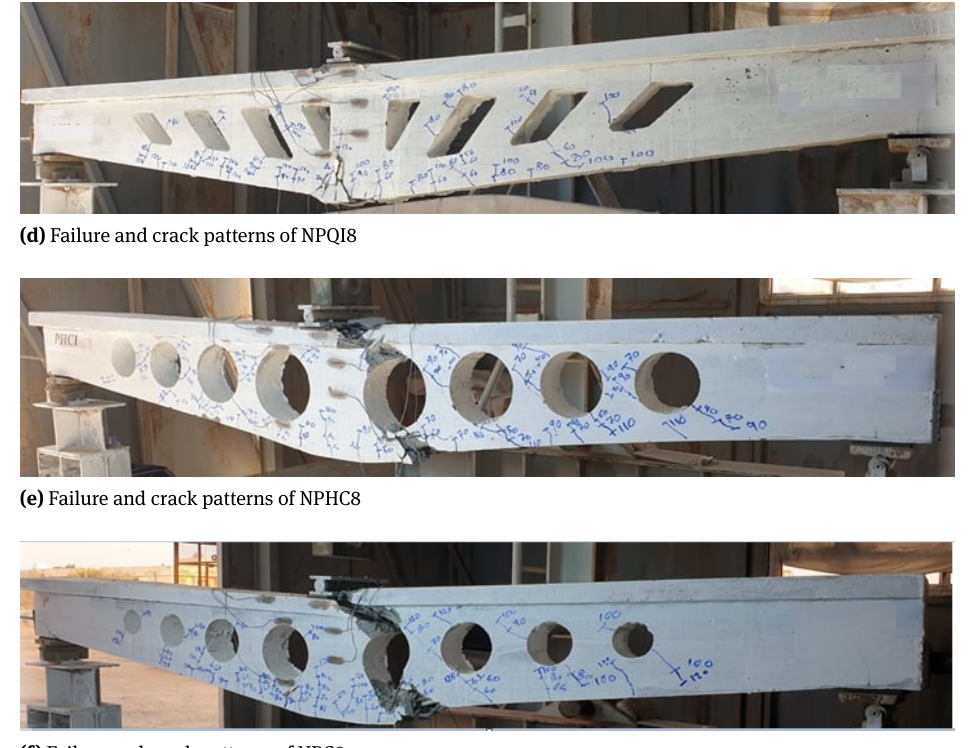
Figure 3: Failure mode and crack patterns of tested